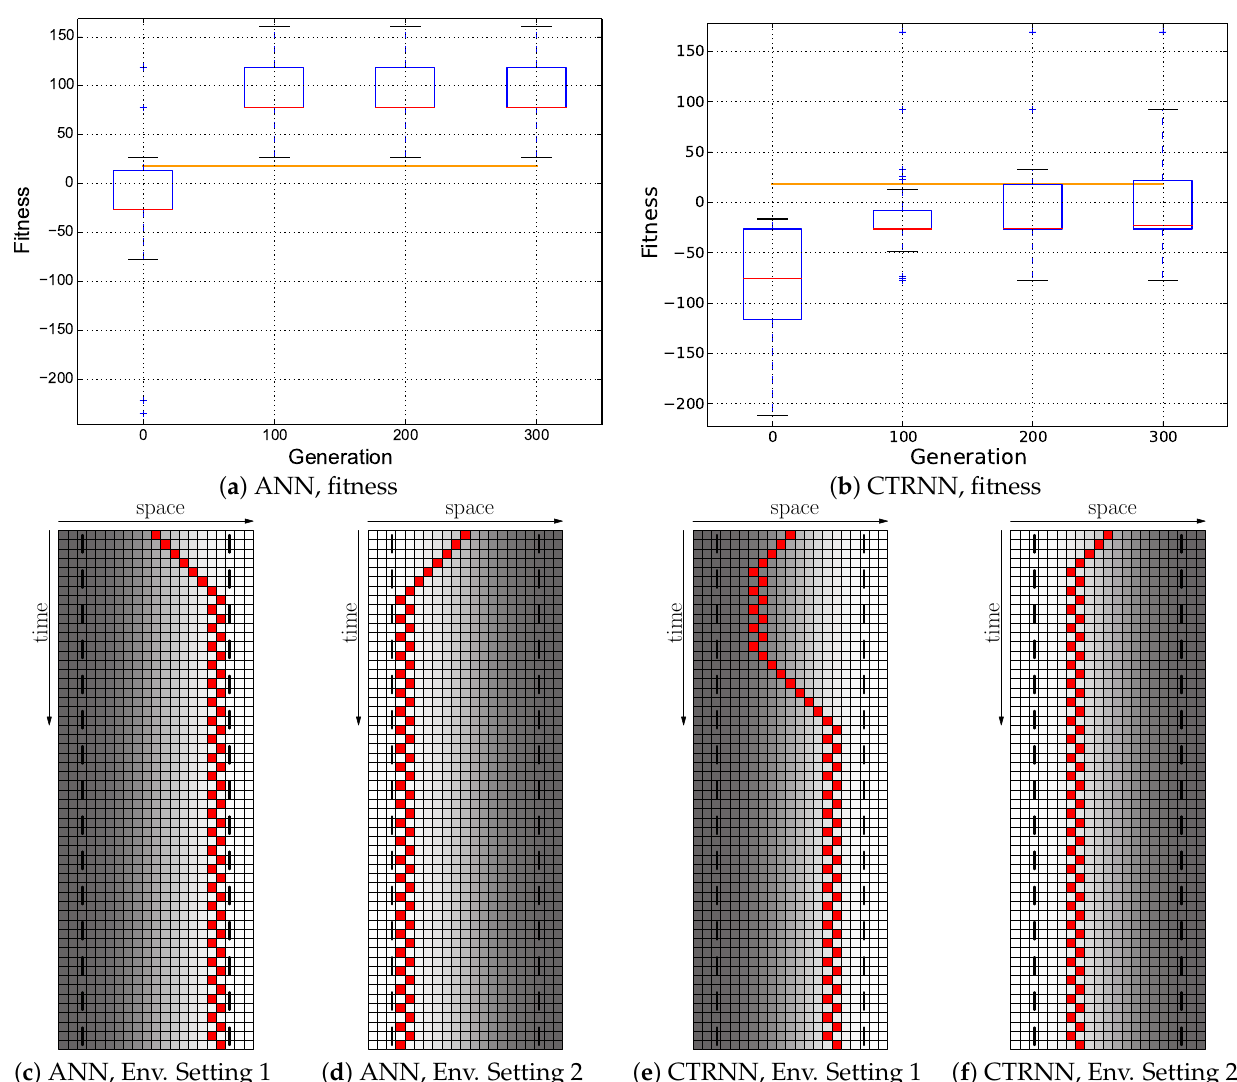
Figure 9. Evolutionary results of the Cumulative fitness regime: fitness = F ( 0,1,0 ) ; the minimum of both evaluations was used as the fitness value for each genome. Top row: fitness dynamics of the ANNs (left) and CTRNNs (right). The horizontal orange line indicates the maximum fitness achievable by a reactive Wankelmut controller, as it was achieved by the simple hand-coded controller. Bottom row: trajectory of the best performing genome of both controller types in both environments used in evolution (only the initial 56 time steps of 250 time steps are